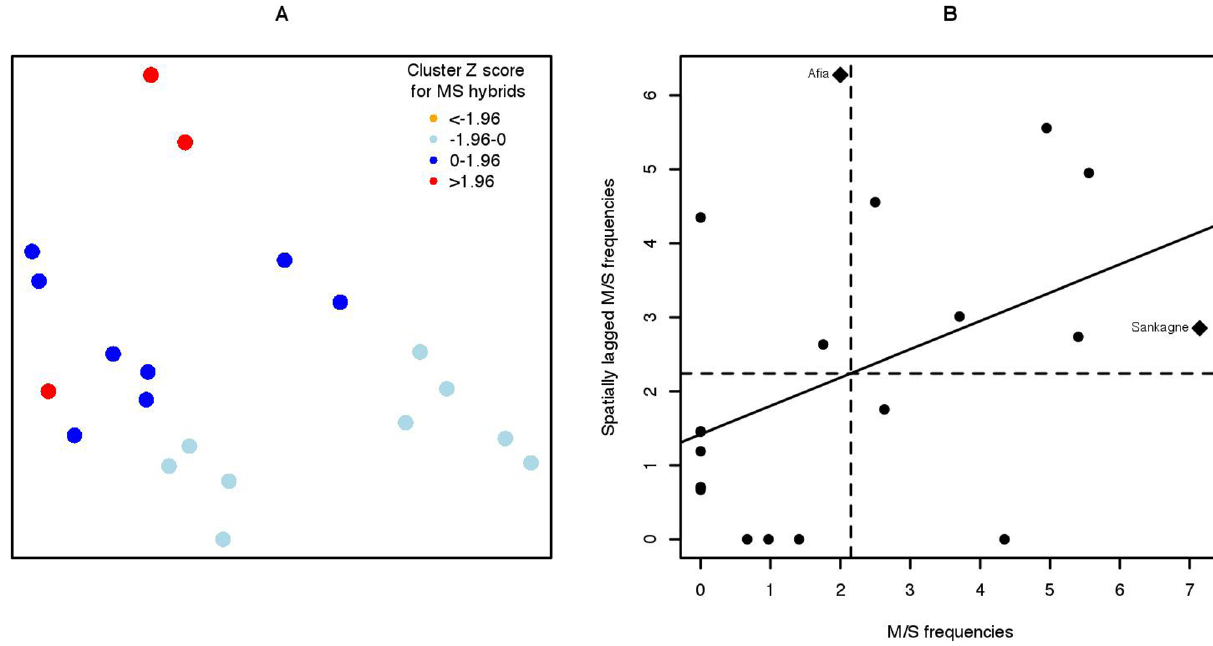
Figure 4. Spatial distribution of M/S hybrids frequencies. Spatial clustering trends (A). Significance of clustering was analysed using the Getis- Ord Gi* statistic [19]. (Z scores . 0 indicates a clustering trend of high MS hybrids frequencies and Z scores , 0 indicates a clustering trend of low MS hybrids frequencies. Significant Z scores (p , 0.05) are in red. Moran scatter plots at site level (B). The names of the sites with large contributions to autocorrelation are displayed.